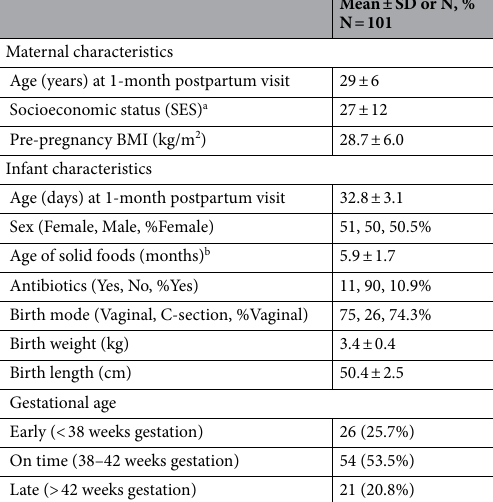
Table 1. Characteristics of 101 mother-infant dyads from the Southern California Mother’s Milk Study, 2016– 2019. Data reported are mean and standard deviation (SD) unless otherwise noted. a Median replacement was performed for missing values (N = 2). b N = 100. SES, socioeconomic status; BMI, body mass